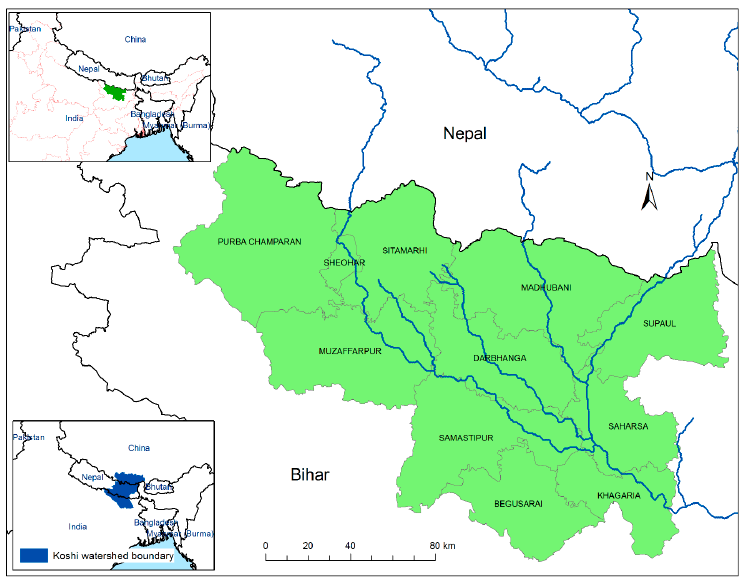
Figure 1. The study area—11 districts in Bihar that lie wholly or partly within the Koshi River basin.